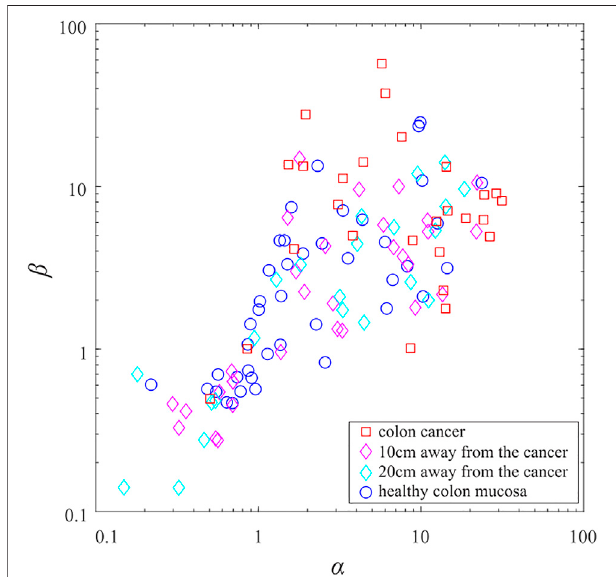
FIGURE 3 | (color online) The scatter plot of beta-distribution parameters. The blue circles correspond to the collagen fi bers from the samples of the healthy colon mucosa. The cyan and magenta diamonds correspond to the samples taken 20 and 10 cm from the colorectal adenocarcinoma. The red squares correspond to the collagen fi bers from the samples of colorectal cancer